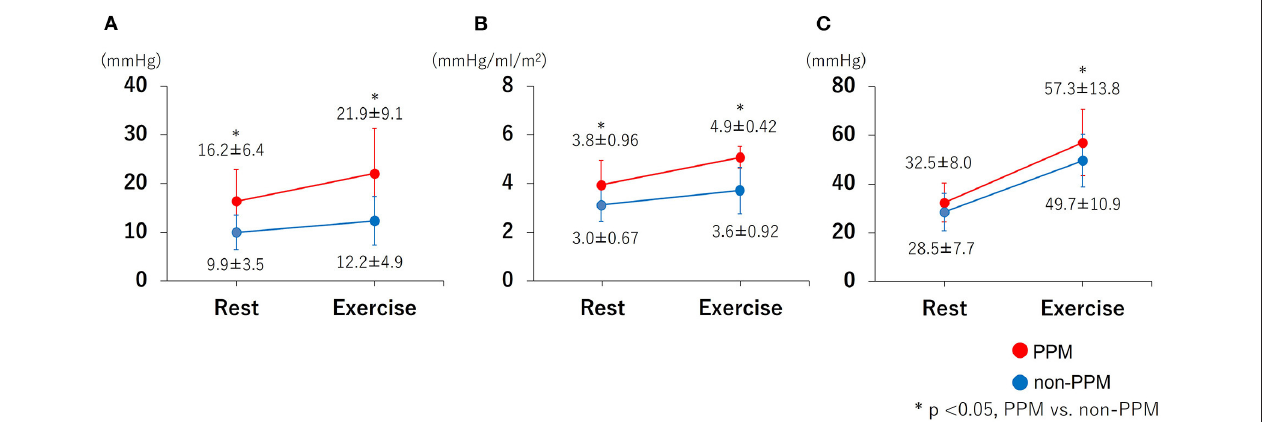
FIGURE 3 | The changes in the mean PG, Zva and SPAP from rest to exercise. (A) mean PG increase from rest to exercise; (B) Zva increase from rest to exercise; (C) SPAP increase from rest to exercise. The increase in the mean PG and Zva from rest to exercise was greater in patients with PPM than in those without PPM. Patients